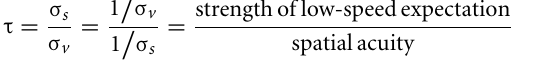
FIGURE 4 | Perceived distance grows linearly with measured distance . (A) The columns display the observer’s likelihood function, prior probability density, and posterior probability density on five trials, in which the measured distance was progressively increased from 2 to 6cm while t was held constant at 0.1s.The mode of the posterior (filled red circle) tracks but lags the measured trajectory (open red circle).To facilitate comparison, yellow